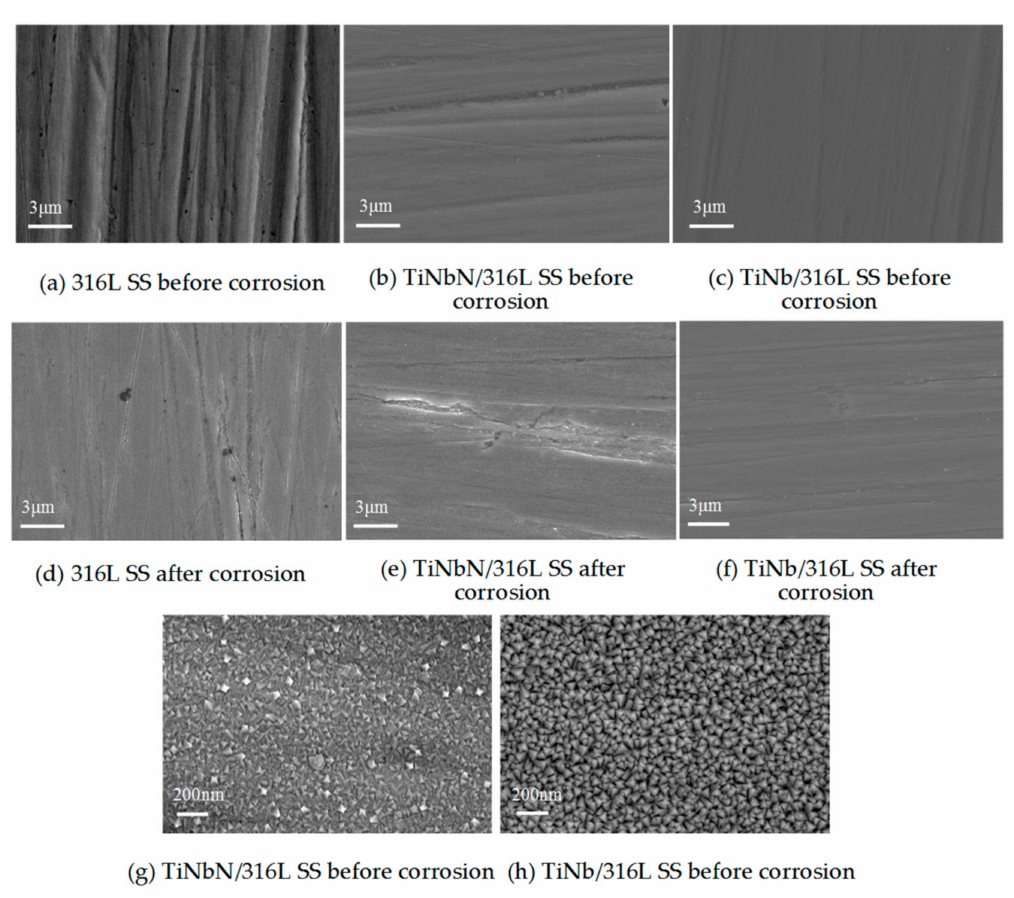
Figure 2. Scanning electron microscopy (SEM) images of the surface of 316L stainless steel (SS), TiNbN / 316L SS and TiNb / 316L